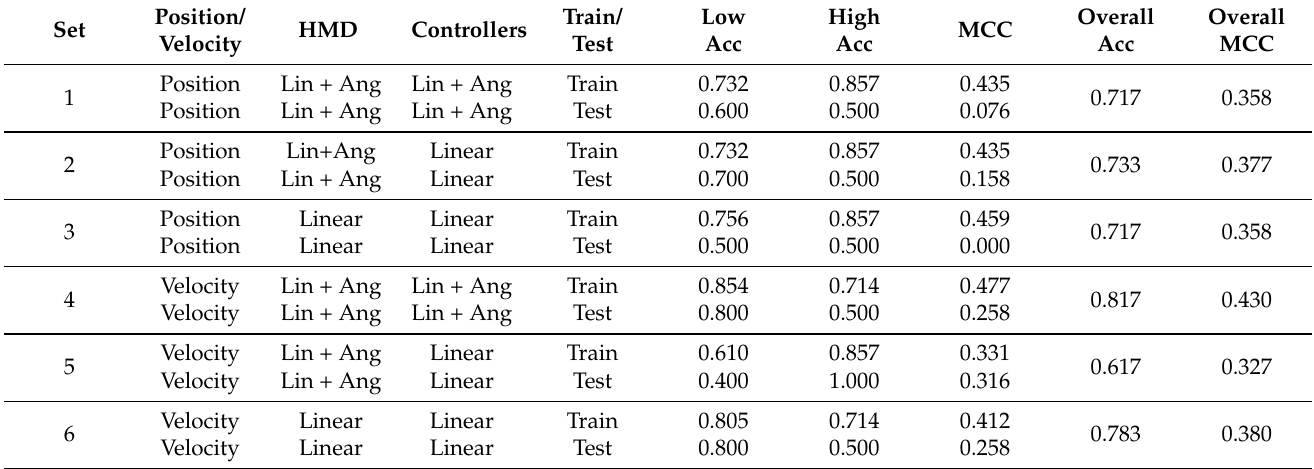
Table 6. Knowledge Retention prediction results. For each of the six sets of input features, the accuracy of the low- performance and high-performance predictions and the MCC are shown for both the training and testing data. Accuracy and MCC are also shown for each set of input features across the entire dataset (i.e., both the training and testing data).